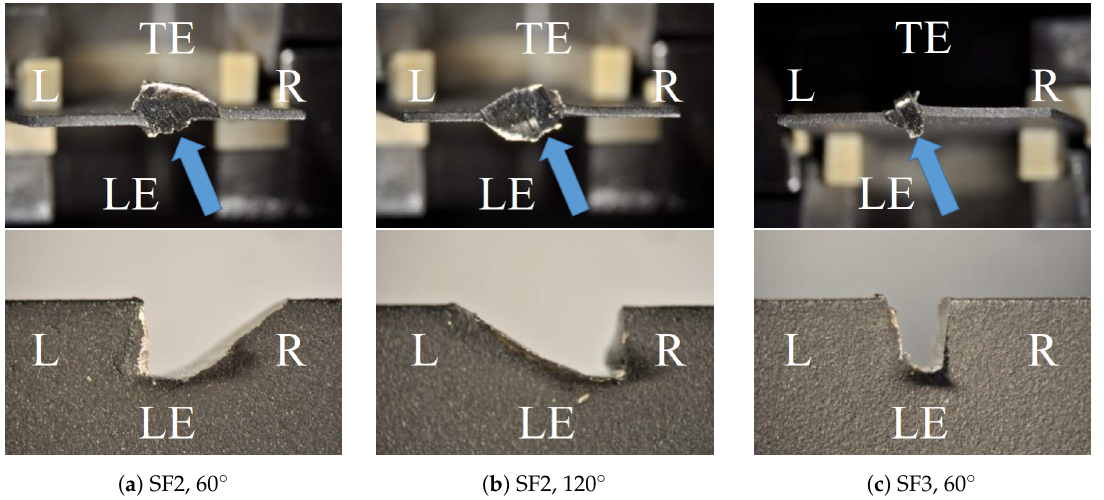
Figure 5. Top and front view of worn metal foils after rubbing, L—left, R—right, LE—leading edge, TE—trailing edge.